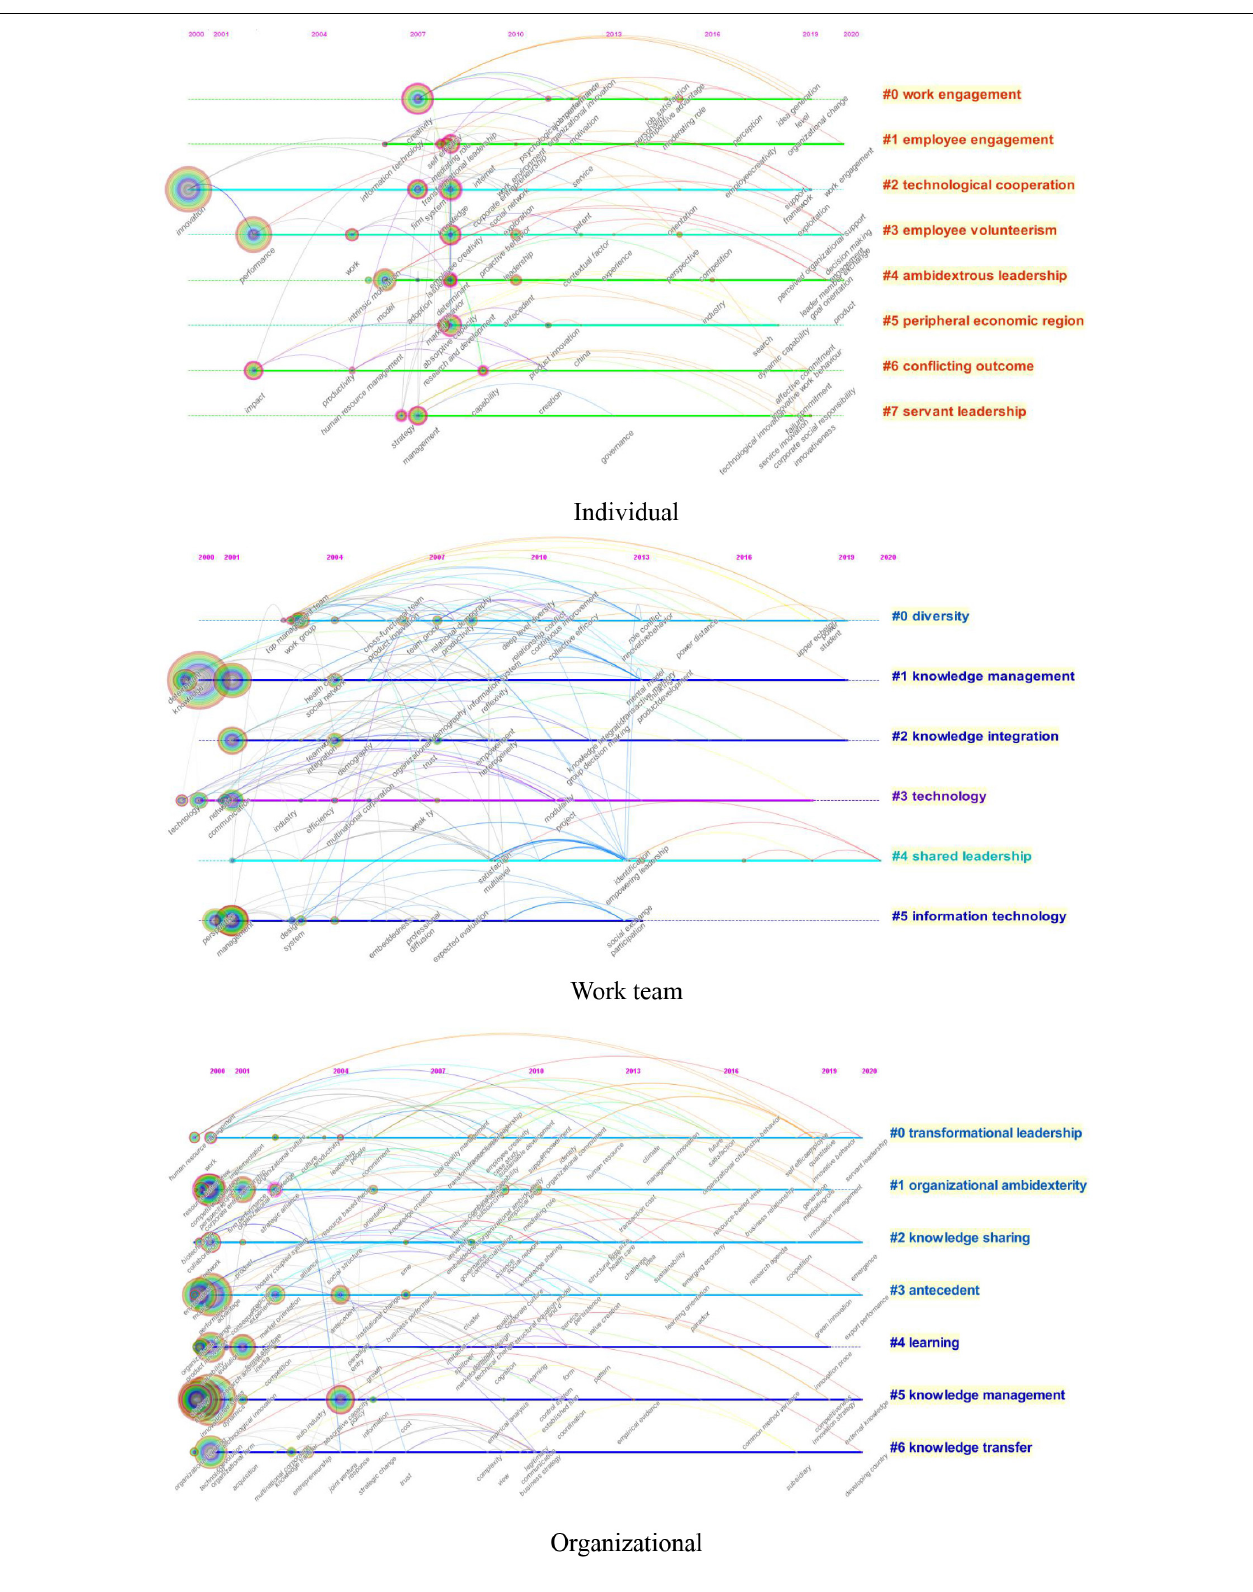
FIGURE 6 | Knowledge maps of the research hotspots of innovation research at different levels (timeline view).